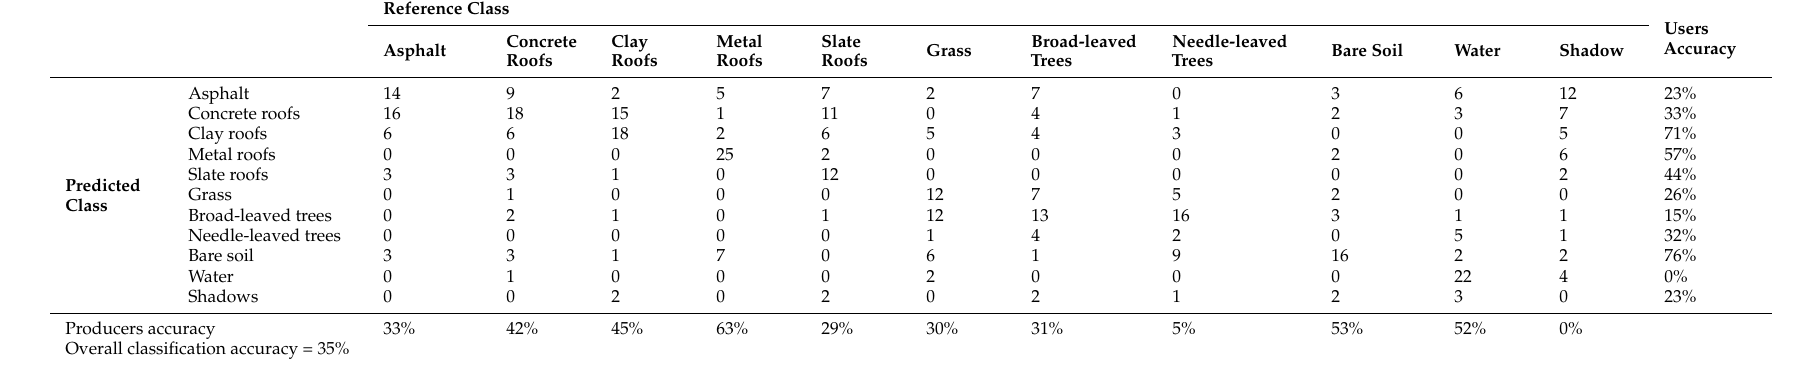
Table 4. Error matrix for the OBIA classification using 30 m spatial resolution, 4 spectral band